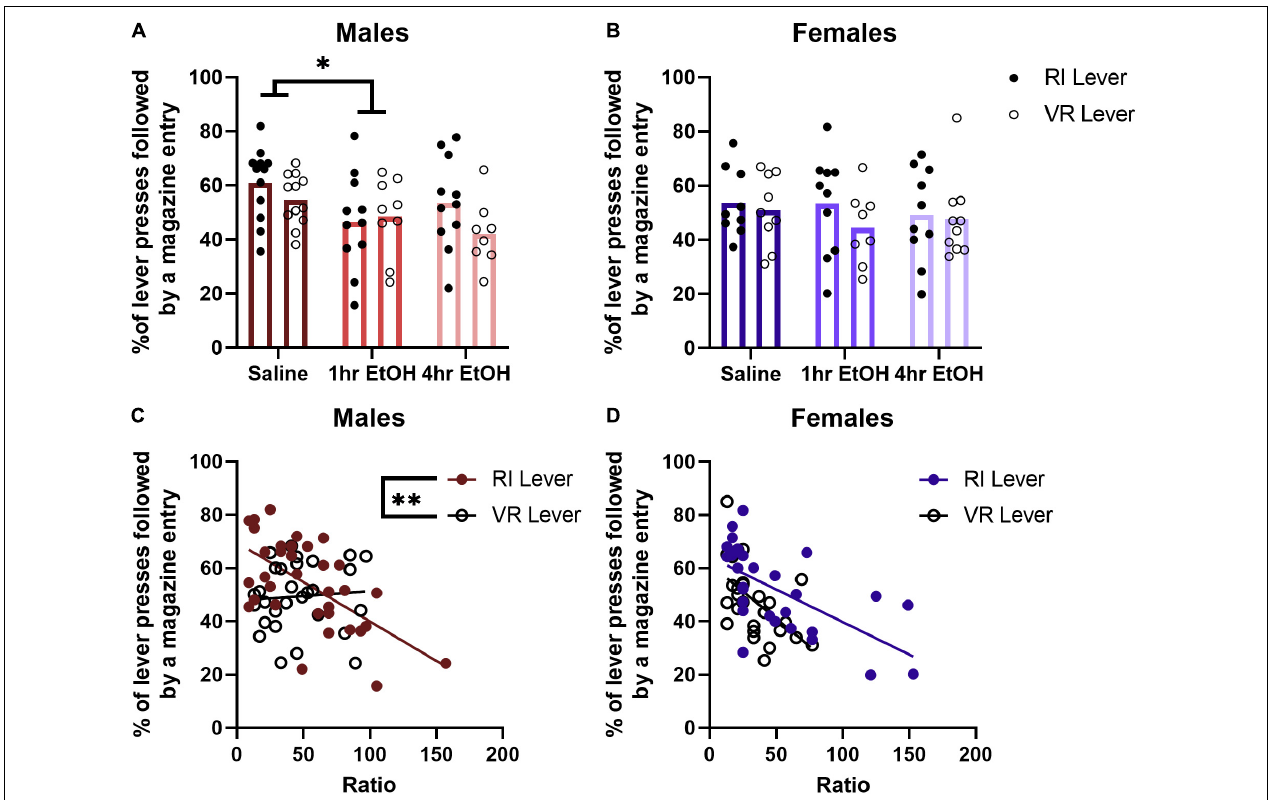
FIGURE 4 | Magazine checking behavior after a lever press is related to performance on the PR. (A) One hour EtOH male mice check the magazine after lever pressing significantly less than saline mice. (B) There are no differences in magazine checking after lever pressing in females. (C) Magazine checking is correlated with performance only on the RI lever in males. (D) Whereas in females, magazine checking is correlated with PR performance on both levers. Data shown as mean ± SEM ( ∗ p < 0.05, ∗∗ p < 0.01).